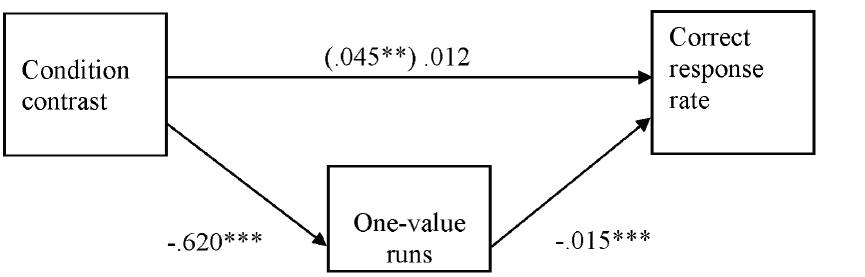
Figure 2. One-value runs as a mediator of the relation between condition contrast and correct response rate (Experiment 1). All coefficients are unstandardized. The coefficient in parenthesis does not control for the effect of one-value runs. **p , .01, ***p ,